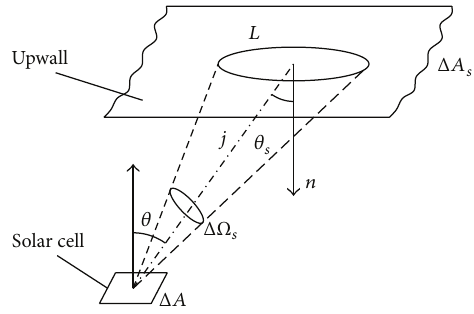
Figure 3: Irradiance of a solar cell from the wall.